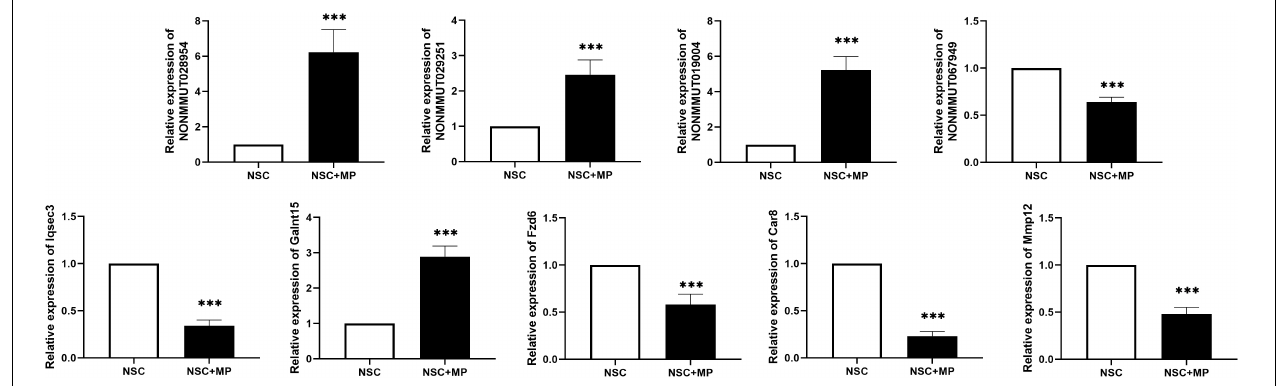
FIGURE 3 | Differentially expressed LncRNA and mRNA confirmation by qRT-PCR. Five pairs of the differentially expressed LncRNAs and their predicted target mRNAs were confirmed by qRT-PCR. The mRNAs Iqsec3 , Fzd6 , Car8 , and Mmp12 were downregulated, and Galnt15 was upregulated. NONMMUT067949 was downregulated, and NONMMUT029251, NONMMUT019004, and NONMMUT028954 were upregulated. N = 9, *** P <